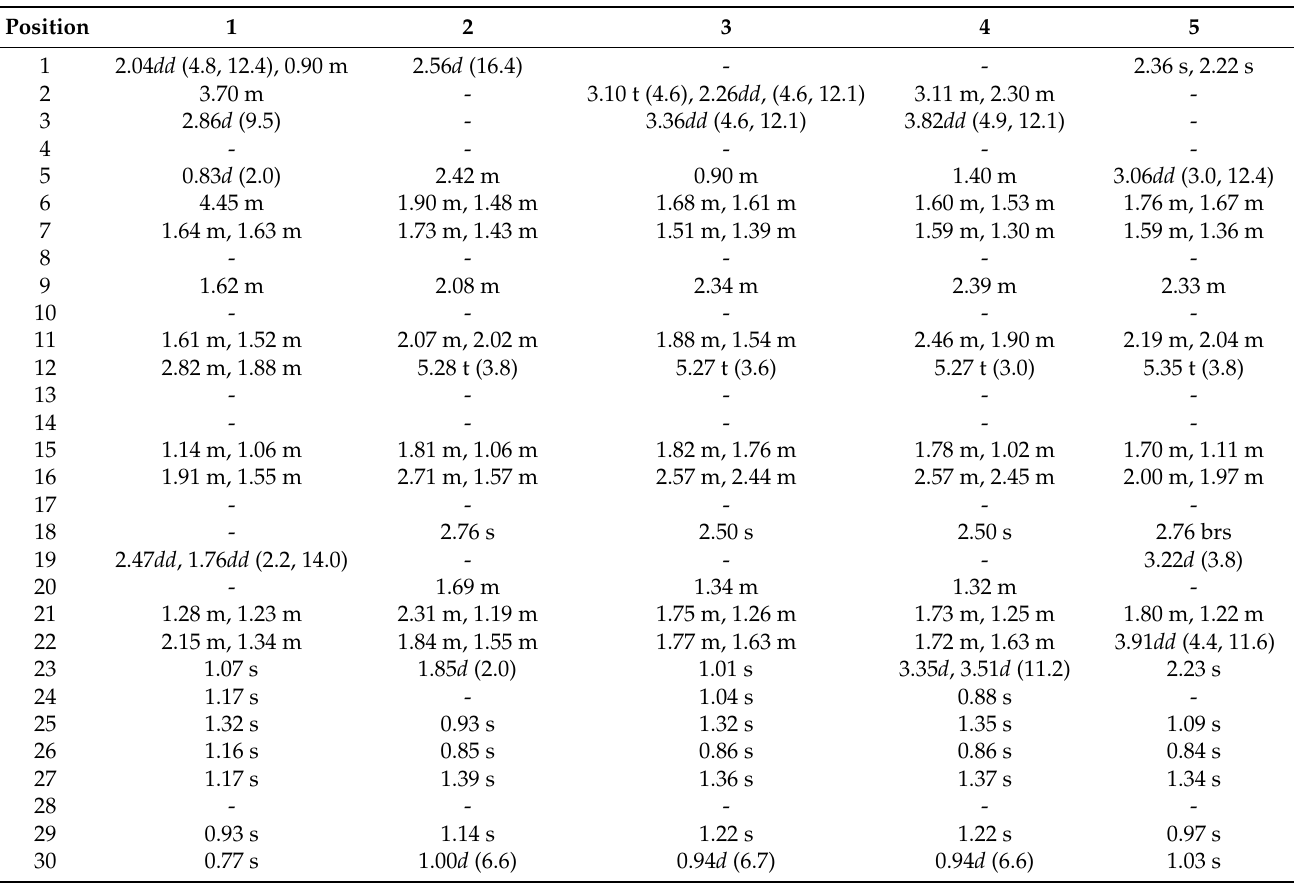
Table 1. H NMR data (500 MHz) for compounds 1 – 5 ( δ , ppm, J , Hz) in CD 3 OD.